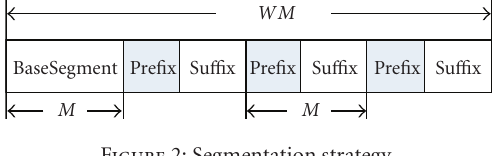
Figure 2: Segmentation strategy.